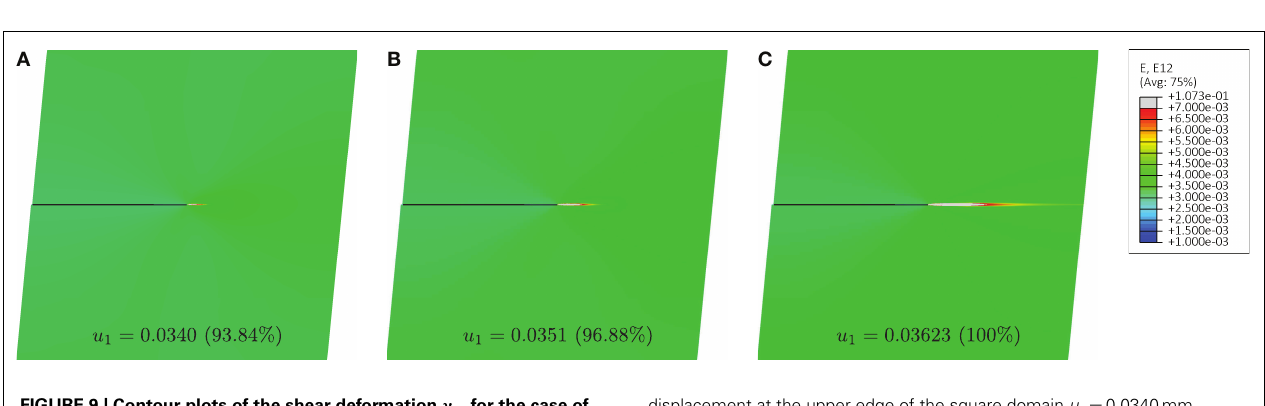
( E p = 150000 MPa) at the same three stages of deformation as those reported in Figure 6 . Although the tip of the shear band acts as a strain raiser, the contour plots show that the level of shear deformation is high and remains diffused in the whole